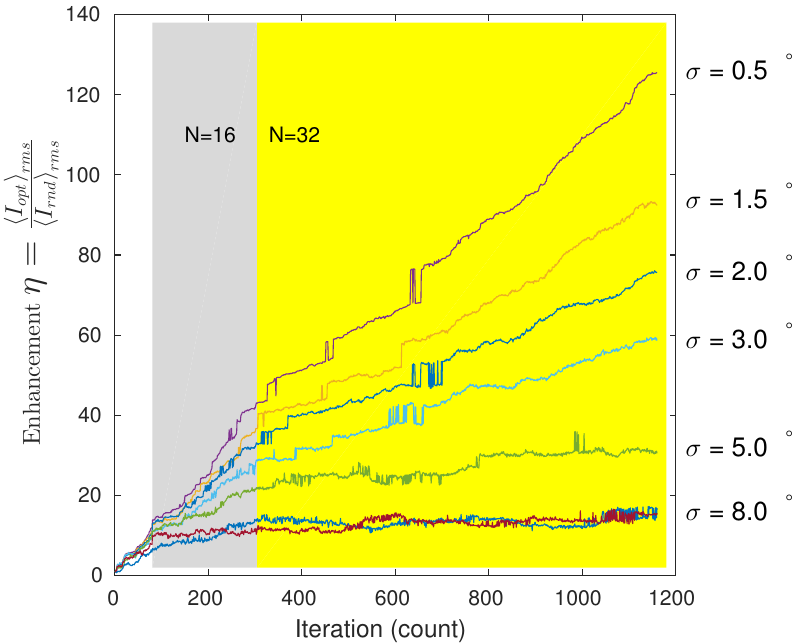
Figure 10. Simulations of reflective inverse diffusion enhancement with zero-mean Gaussian distributed random phase fluctuations added to the reflector model. With the exception of σ = 8 ◦ , all reflector models are unimodular with a uniformly-distributed random phase. For σ = 8 ◦ , both the uniformly-distributed random phase model (red) and the circular Gaussian model (blue) are shown. The N = 16 iterations are highlighted in gray. The N = 32 iterations are highlighted in